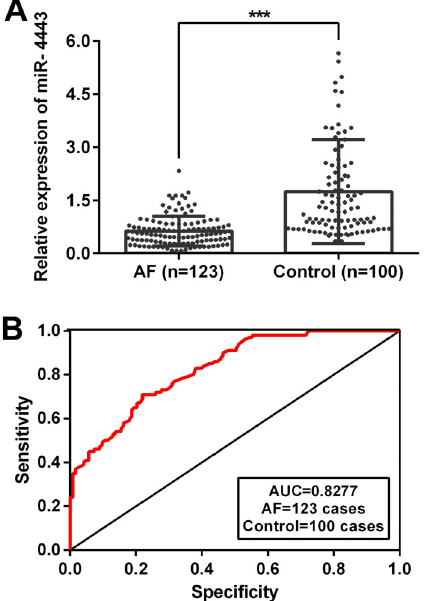
Figure 1. hsa-miR-4443 decreased in patients with atrial fi brillation (AF). A , Serum hsa-miR-4443 expression level was determined by qRT-PCR. B , ROC analysis was performed to evaluate the diagnostic ef fi cacy of serum hsa-miR-4443 for persistent AF. Horizontal lines indicate median and interquar- tile range. ***P o 0.001 vs control (Mann-Whitney U test, two-